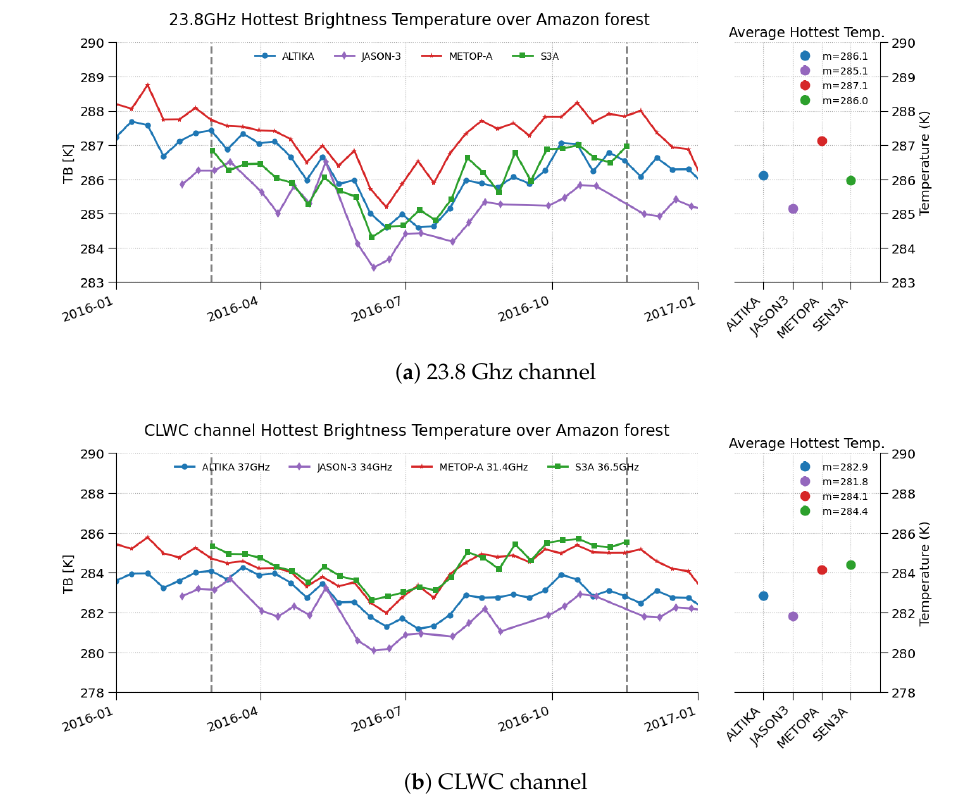
Figure 9. Time series of hottest brightness temperatures over Amazon forest at 23.8 GHz ( a ) and CLWC channel ( b ) for AltiKa, Jason-3, MetOp-A and Sentinel-3A. The right panels are showing the average temperature computed over the period defined by the two vertical dotted